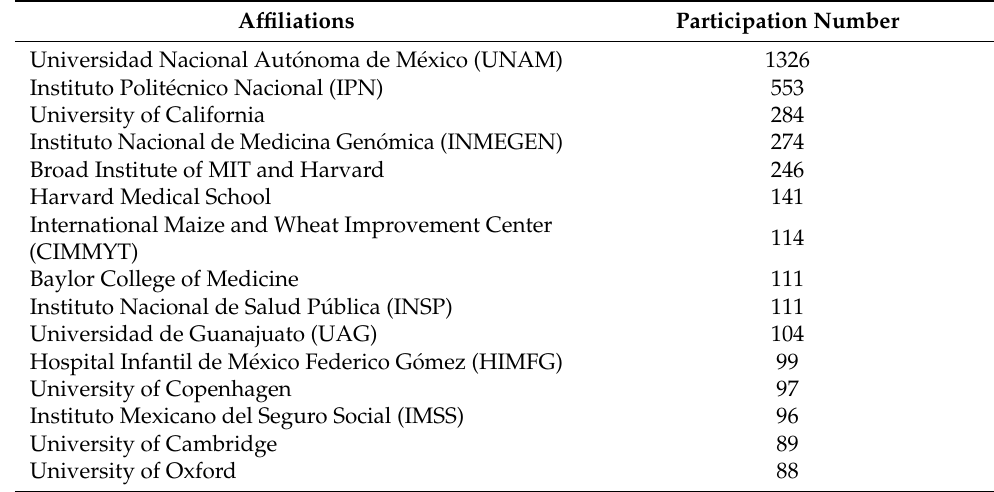
Table 2. Most relevant Institutions publishing articles associated with Mexican bioinformatics for the 1994–2018 period a